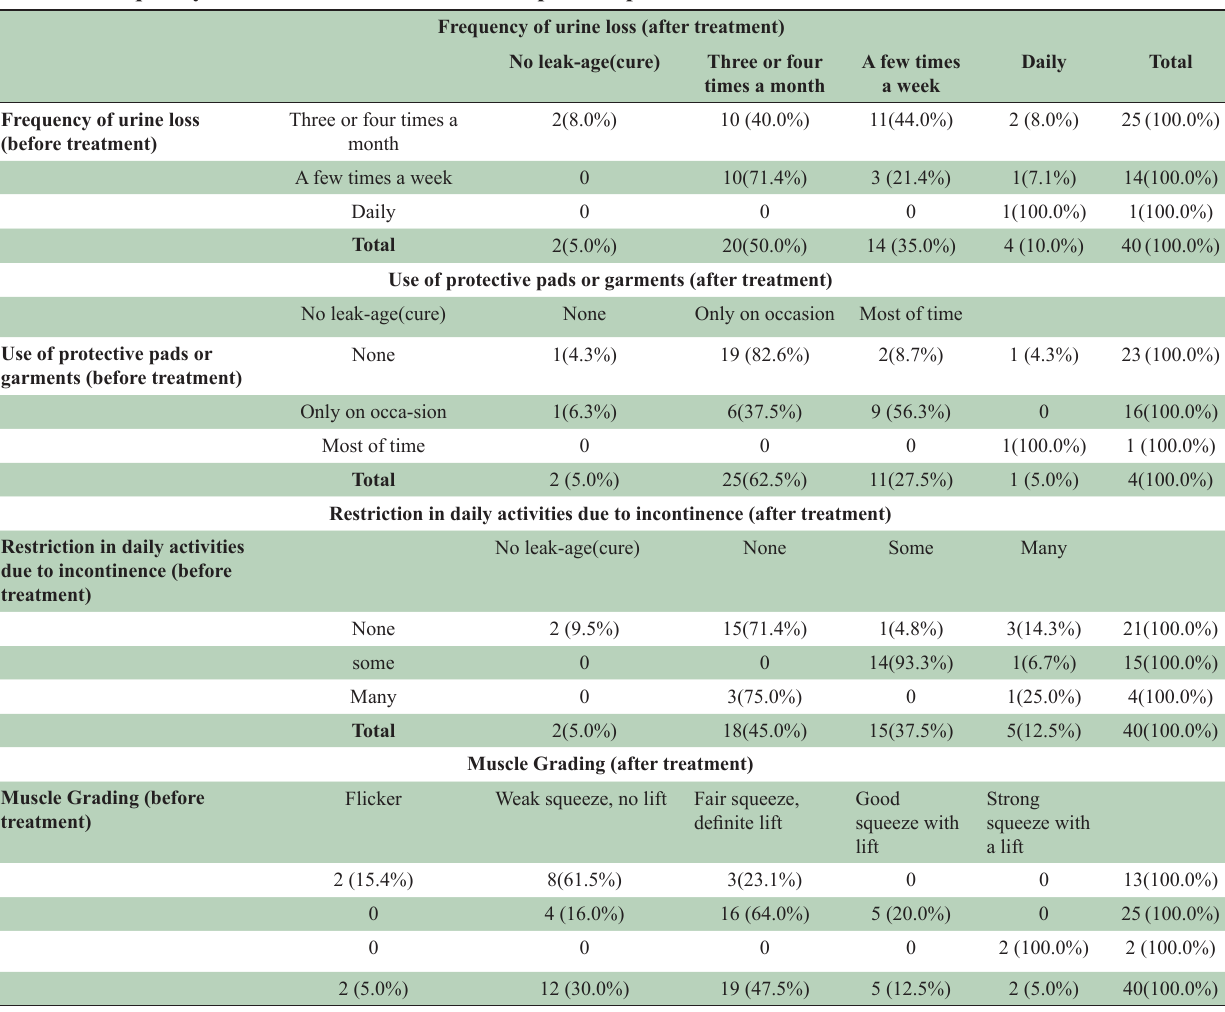
Table-II: Frequency of Urine Loss and Use of Pads pre and post